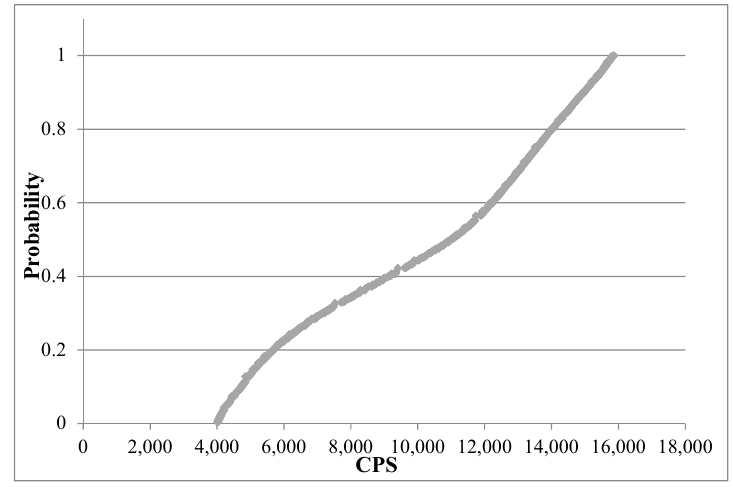
Figure 1. Cumulative Distribution Function: CPS (Million